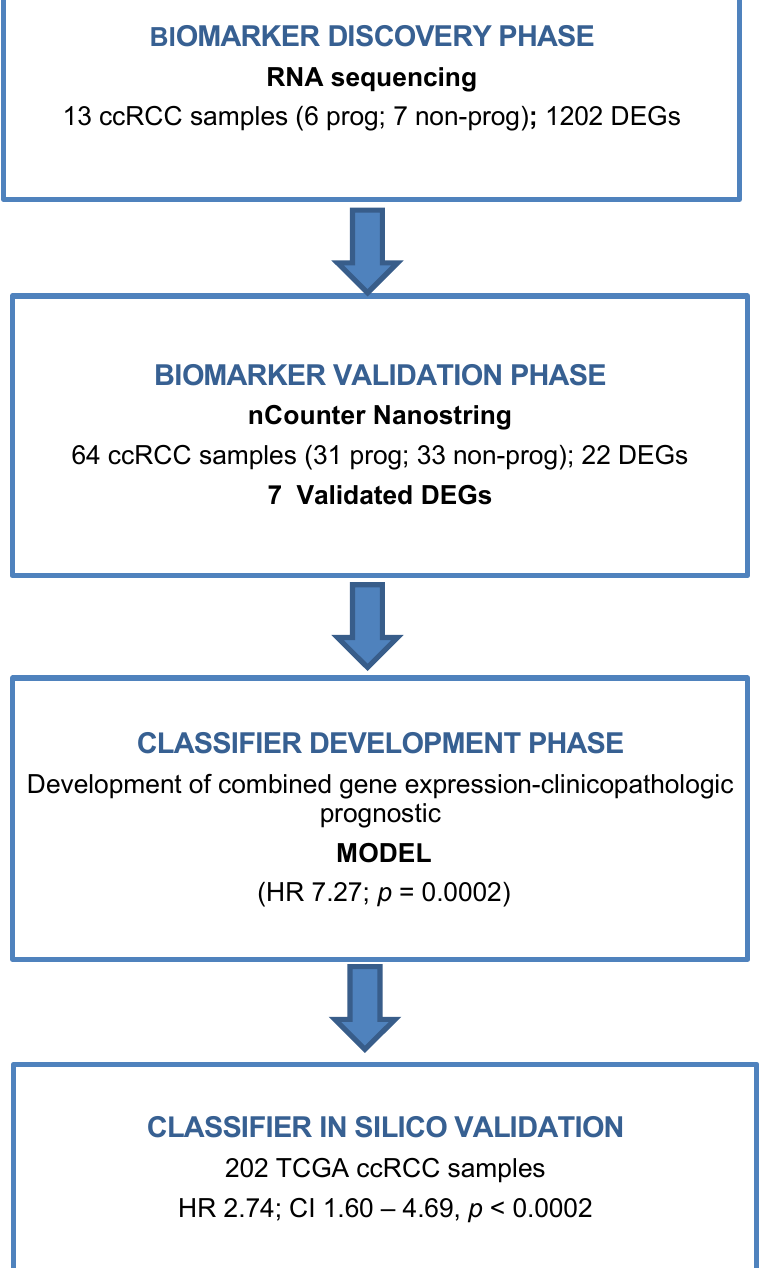
Figure 4. Study outline. Tissue samples were obtained from a total of 77 patients with intermediate/high-risk ccRCC. Samples were split into a biomarker discovery ( N = 13) and validation ( N = 64) phase. Transcripts differentially expressed between progressive and non-progressive intermediate/high-risk ccRCCs were first identified in the discovery phase using RNAseq. Twenty-two DEGs were selected for validation in an independent set of 64 tissue samples using nCounter Elements (Nanostring). A prognostic model was generated using gene expression and clinical data in the classifier development phase. Finally, the prognostic model was in silico validated using a TCGA cohort. Abbreviations: ccRCC, Clear cell renal cell carcinoma, DEGs, Differentially expressed genes.